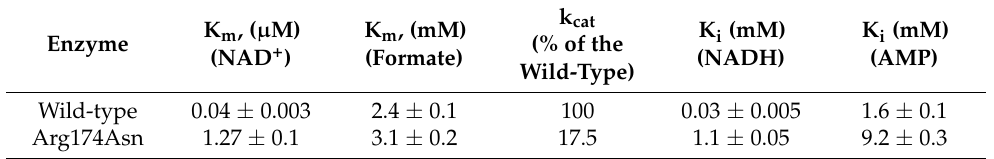
Table 1. Steady-state kinetic parameters for the wild-type and mutant Arg174Asn enzymes.